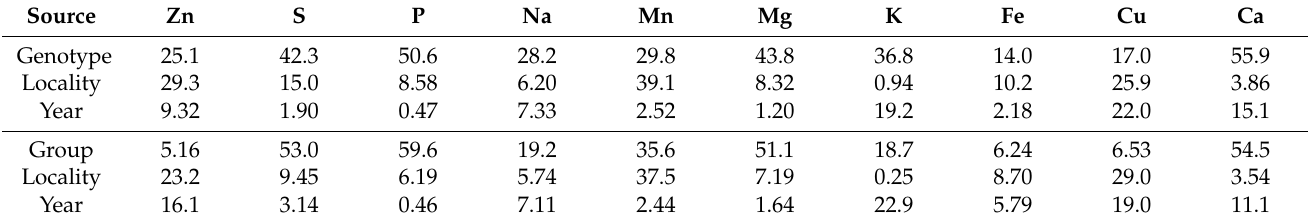
Table 4. Percentage of explanation (obtained through the coefficient of determination [R 2 ] from simple linear regression analyses) of 12 genotypes across four locations and three years, and 7 genotype groups across four locations and three years, on amount of various